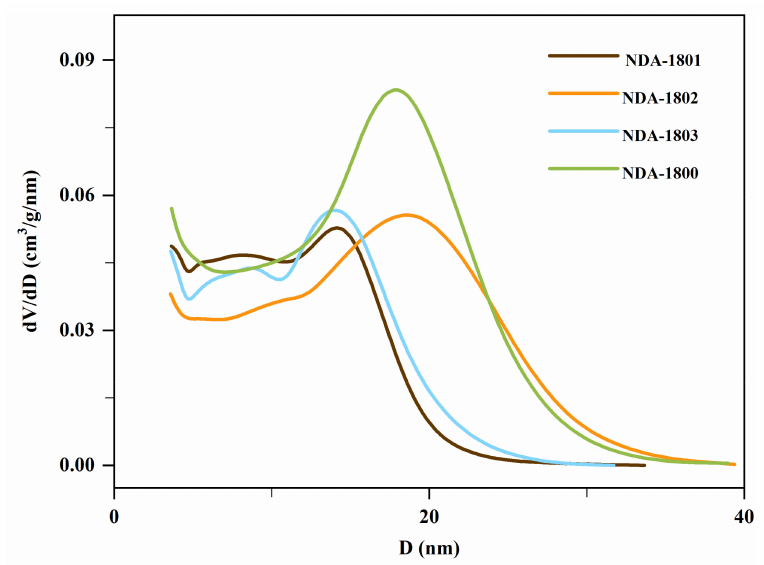
Figure 4. Mesopore diameter distribution of NDA-1800, NDA-1801, NDA-1802, and